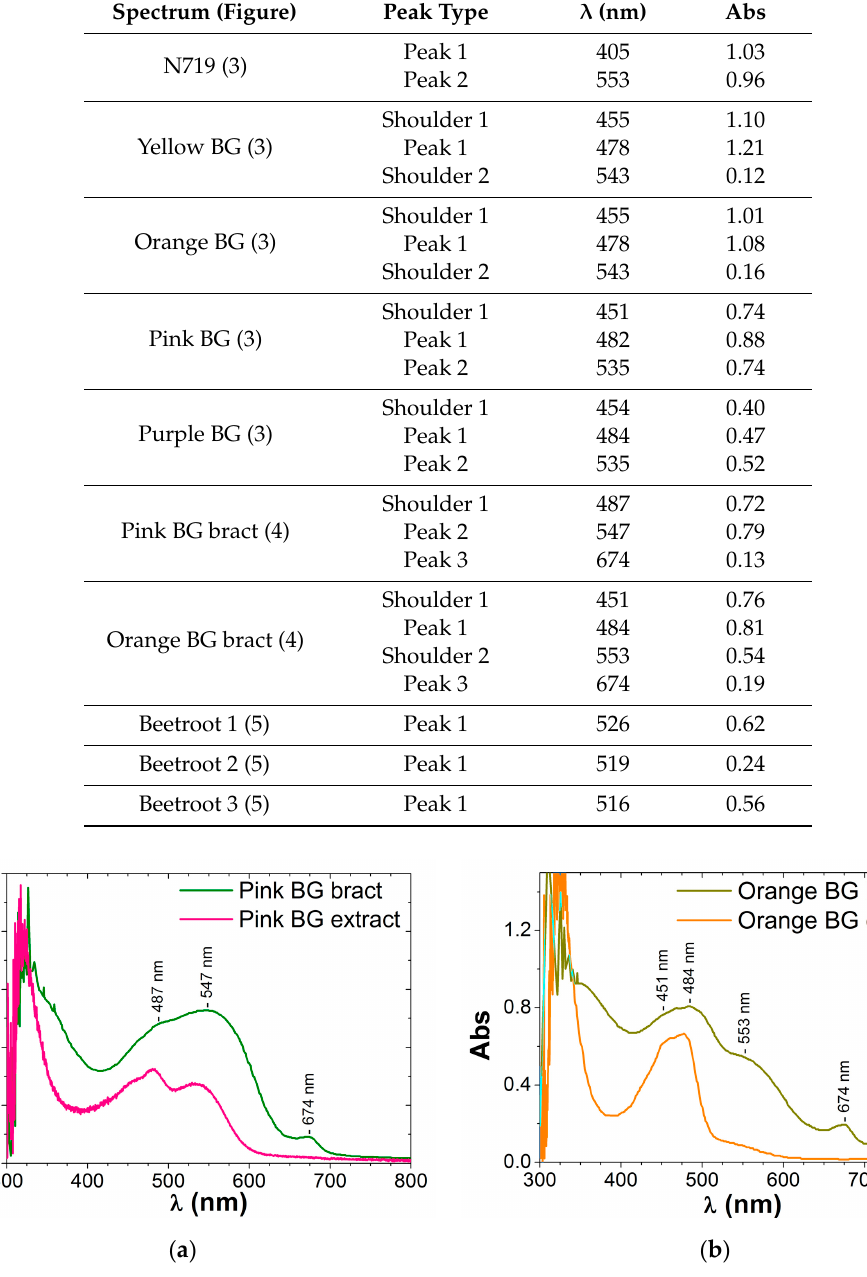
Table 2. Wavelength and intensity of the main absorbance peaks of the UV-Vis spectra shown in Figures 3–5.